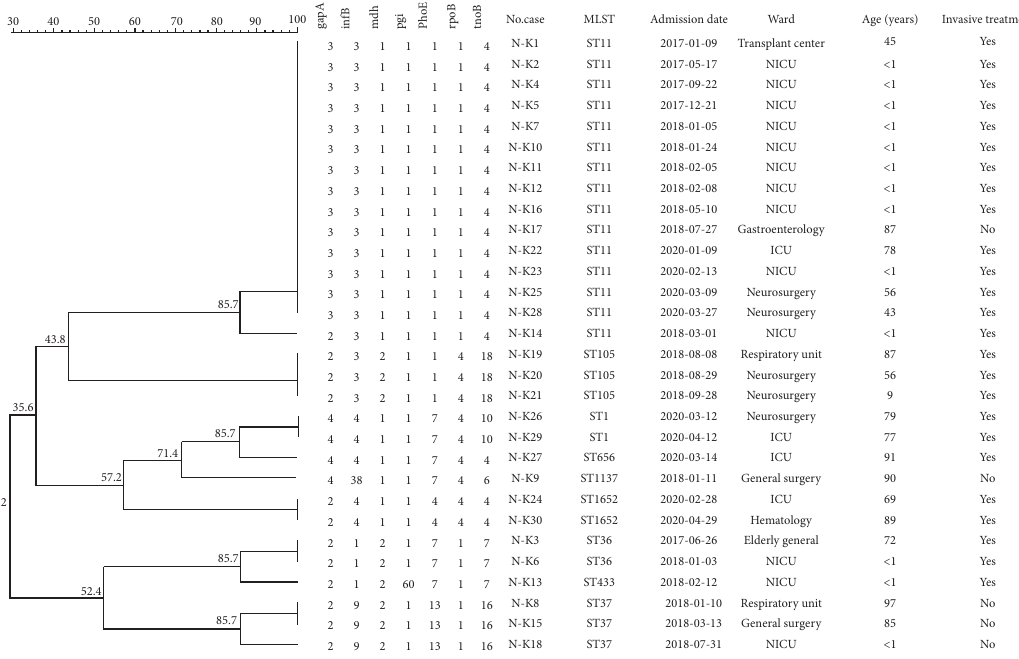
Figure 1: The specific sequence similarity cluster analysis.